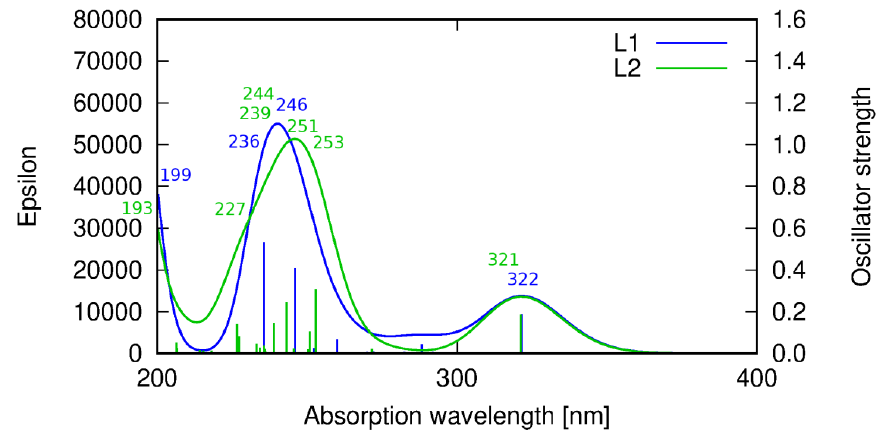
Figure 8. Theoretical prediction of the absorption spectrum of ligands HL1 (blue line) and HL2 (green line) in acetonitrile calculated with the PBE0 functional. Sticks correspond to the precise theoretical transition wavelength and oscillator strength, while the convoluted spectrum is obtained as their Gaussian